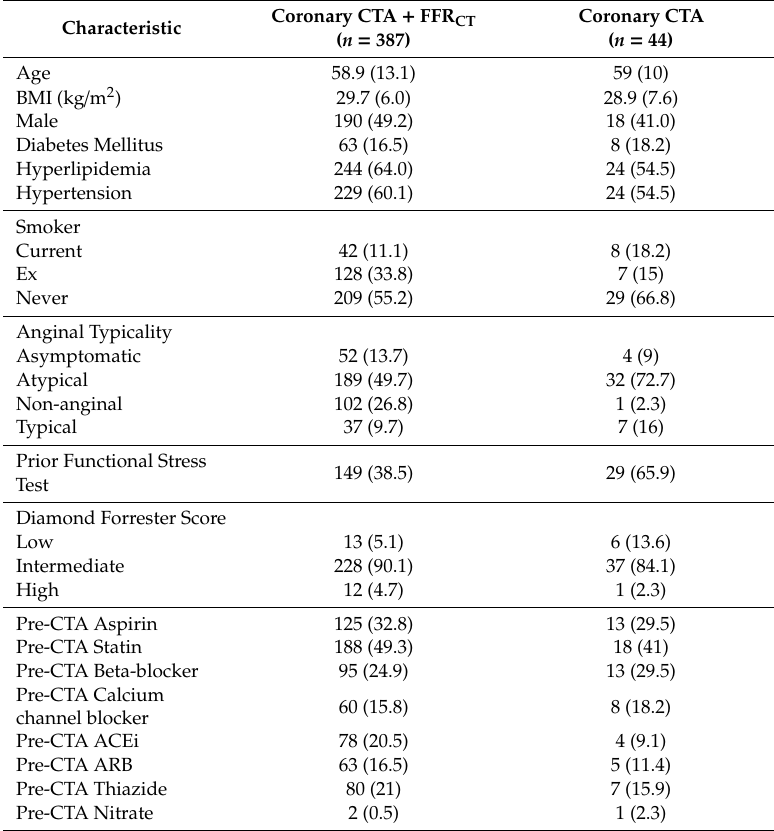
Table 1. Baseline patient